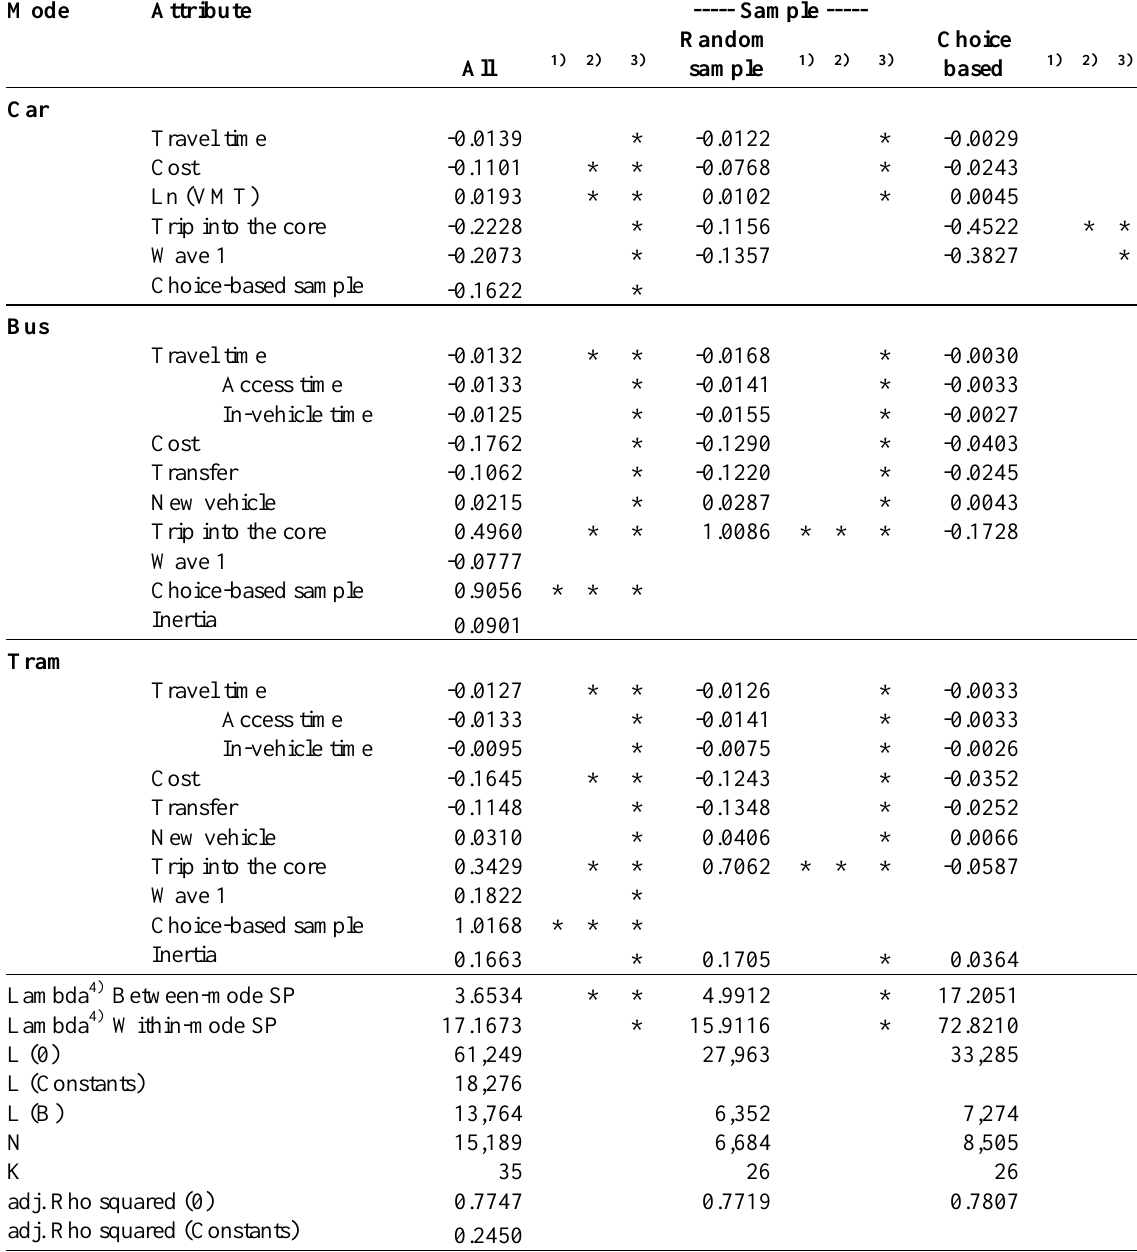
Table 7. Joint RP and SP estimation: NL-model